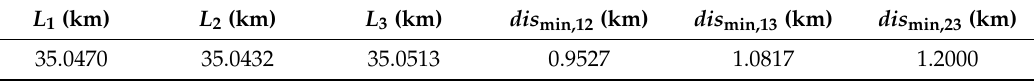
Table 6. Lengths of three paths and their minimum separation distances (3-D).